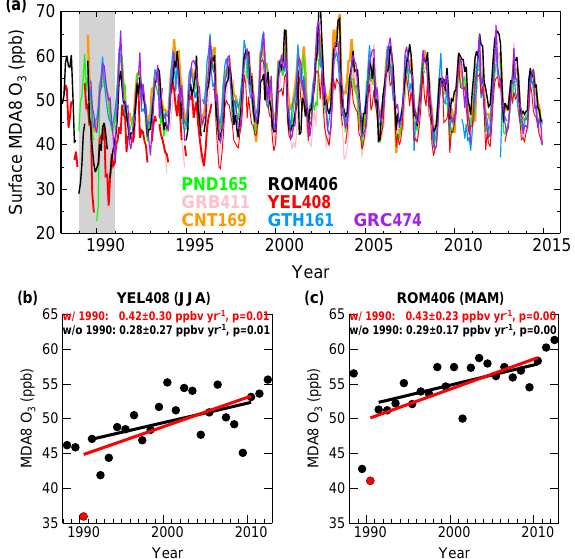
Figure 2. Measurement uncertainties. (a) Comparison of observed monthly mean MDA8 O 3 at WUS CASTNet sites. All sites have more than 90% data availability in every month shown. The gray shading denotes the period when data at Yellowstone (red) and Rocky Mountain (black) were inconsistent with the other sites. (b– c) The 1990–2010 trends of median JJA MDA8 O 3 at Yellowstone and median MAM MDA8 O 3 at Rocky Mountain with and without data in